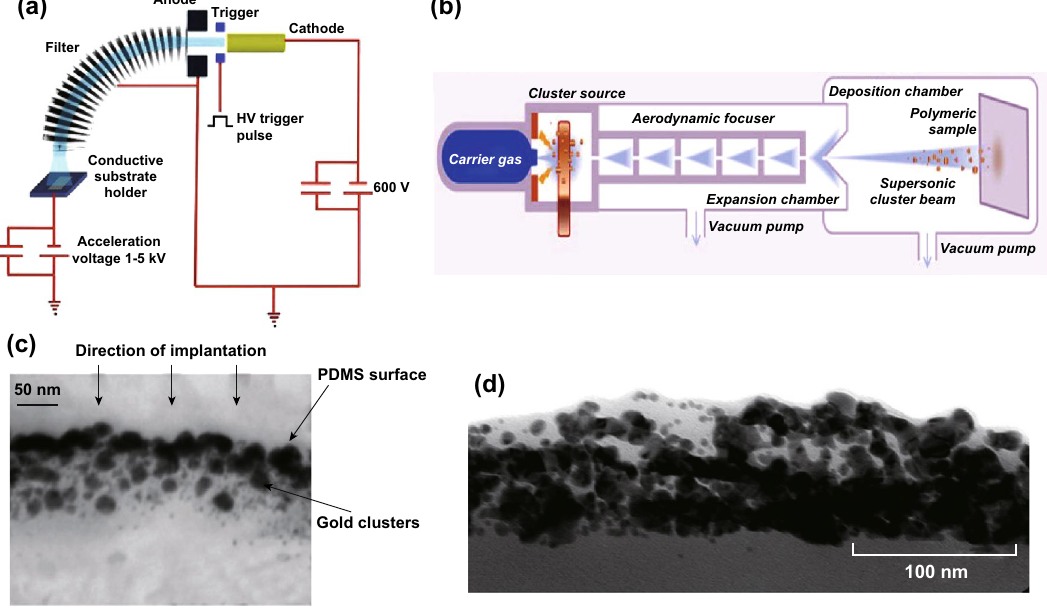
Fig. 2 a The schematic picture of FCVA. Adapted from Ref. [59] with permission. A high-voltage (600 V) impulsion initiates the main arc from the cathode, the filter helps to trap the macroparticles and the negatively substrate holder accelerates the positive ions through the plasma sheath. b The schematic of SCB progress. Adapted from Ref. [63] with permission. The Au NPs nanoparticles generated from the cluster source is accelerated by a carrier gas in a supersonic expansion and then focused by aerodynamic lens. The cluster beam can be injected into the deposi- tion chamber and impacted on the surface of a thermo-retractable polystyrene (PS) sheet. c The product of FCVA. Adapted from Ref. [47] with permission. d TEM image of the product of SCB. Adapted form Ref. [63] with